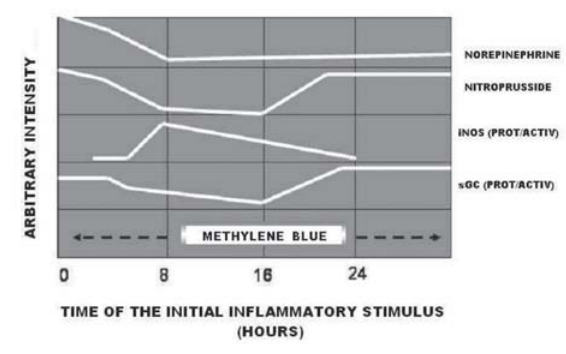
Fig. 5 - “Window of opportunity” for methylene bule use depending on activity of soluble guanylate cyclase (sGC); iNOS = inducible nitric oxide synthase. Prot = protein. Adaptation of Fernandes, 2001 (Reference